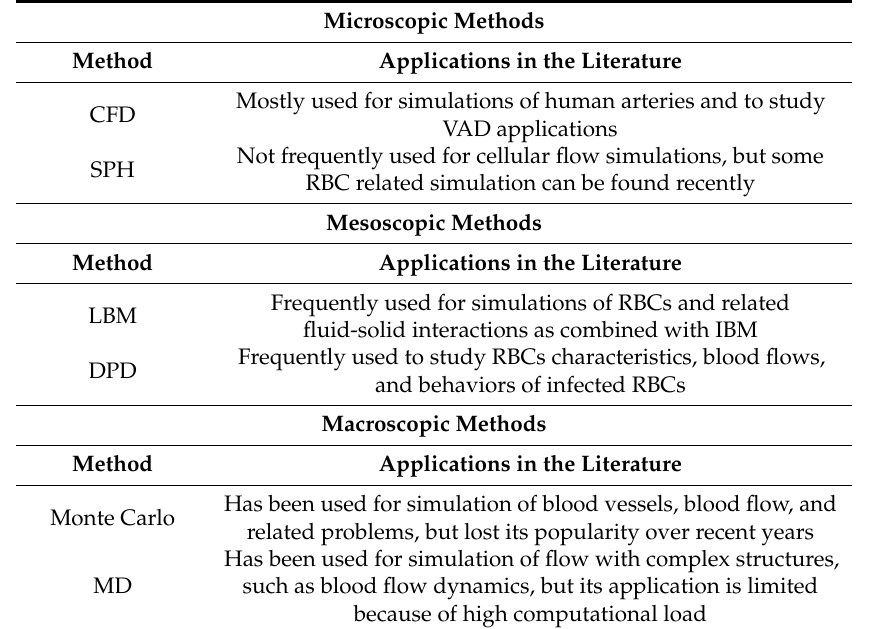
Table 3. Summary of main numerical methods presented in this work and applicability of them in similar